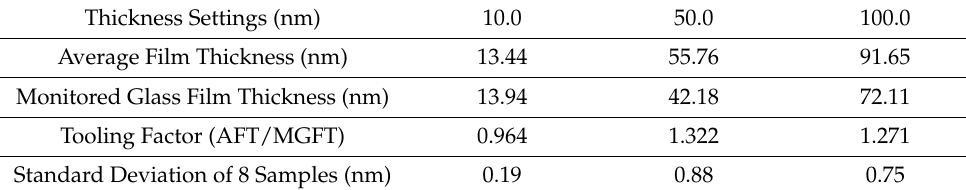
Table 3. Analysis results of single-layer SiO 2 film coated with various thicknesses. Thickness Settings